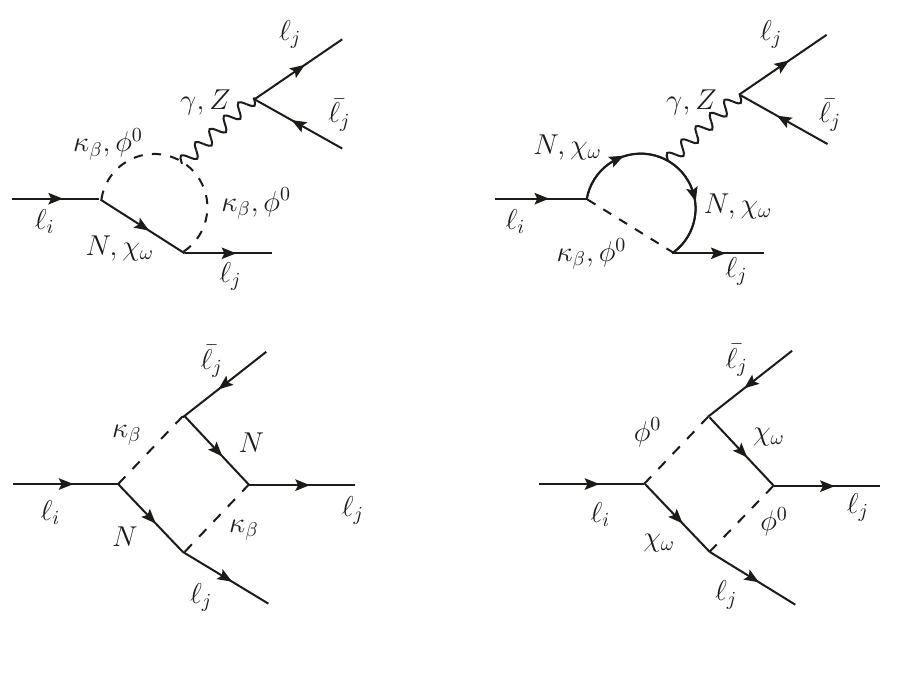
Figure 3 . One-loop diagrams contributing to ‘ i ! ‘ j (cid:22) ‘ j ‘ j decays, where (cid:30) 0 denotes the two Z 2 -odd neutral scalars A 0 and H 0